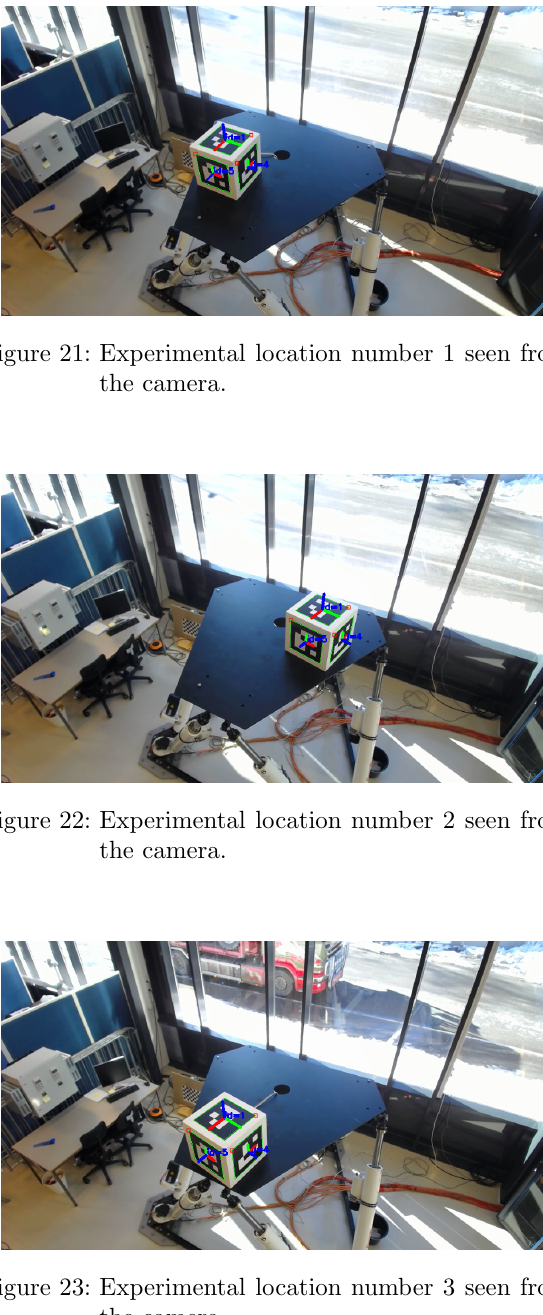
Figure 26: Experimental location